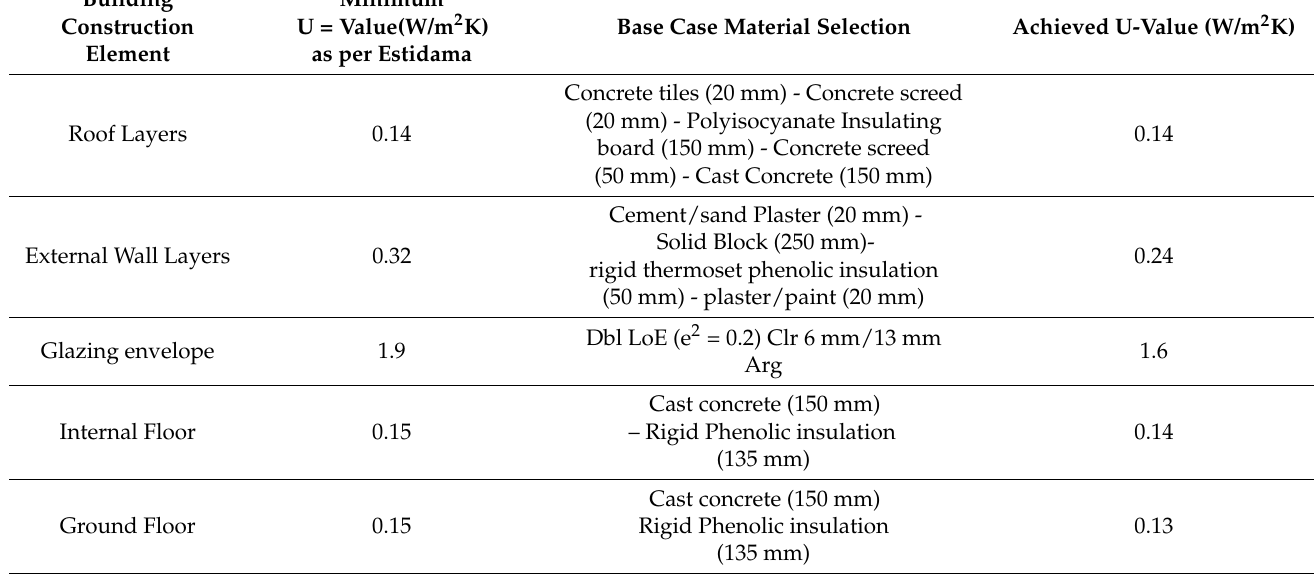
Table 4. The base case material selection as per Estidama